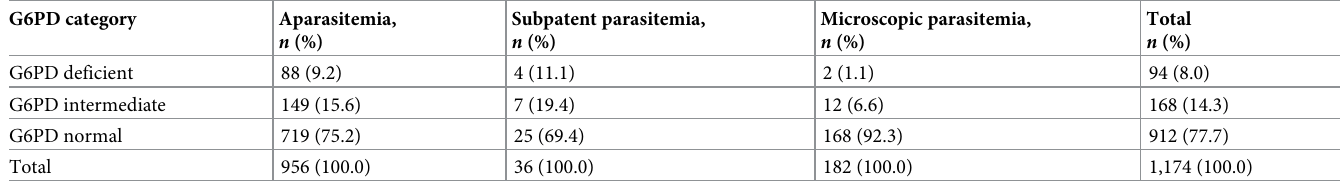
Table 3. Proportions of phenotypic G6PD deficient, intermediate, and normal participants among individuals with no parasitemia, parasitemia confirmed by PCR only, and parasitemia confirmed by microscopy.